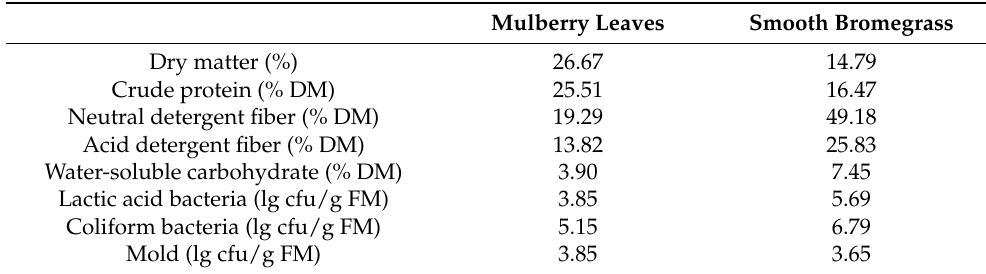
Table 1. Chemical compositions and microbial populations in mulberry leaves and smooth bromegrass before